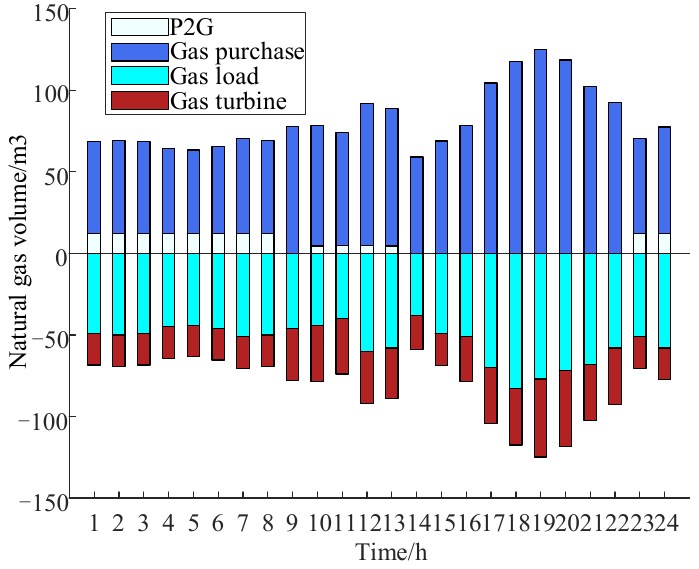
Figure 6. Gas power optimization diagram.